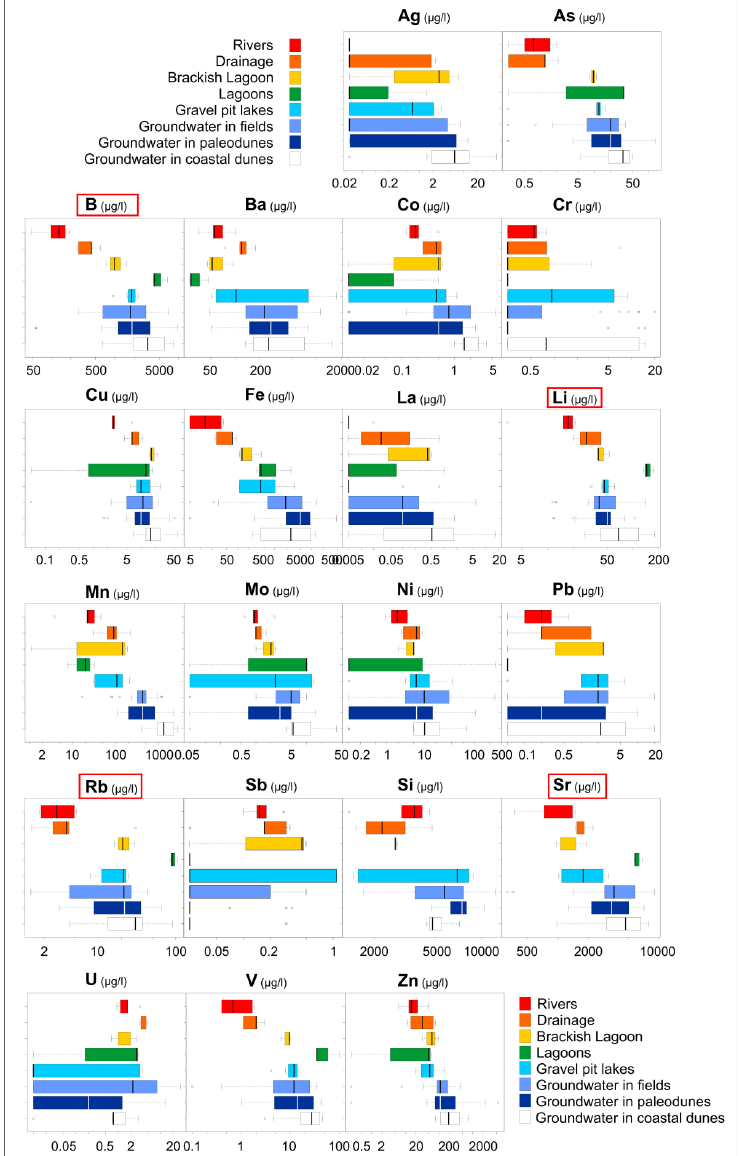
Figure 8. Box plots of TEs concentrations of all water samples grouped by environments. Environment groups order shows surface water from fresh (Rivers) to saline (Lagoons) and then groundwater from inland (Gravel pit) to sea (Groundwater in coastal dune). TEs are in alphabetic order. B, Li, Rb and Sr are highlighted by red boxes to indicate their conservative behavior.